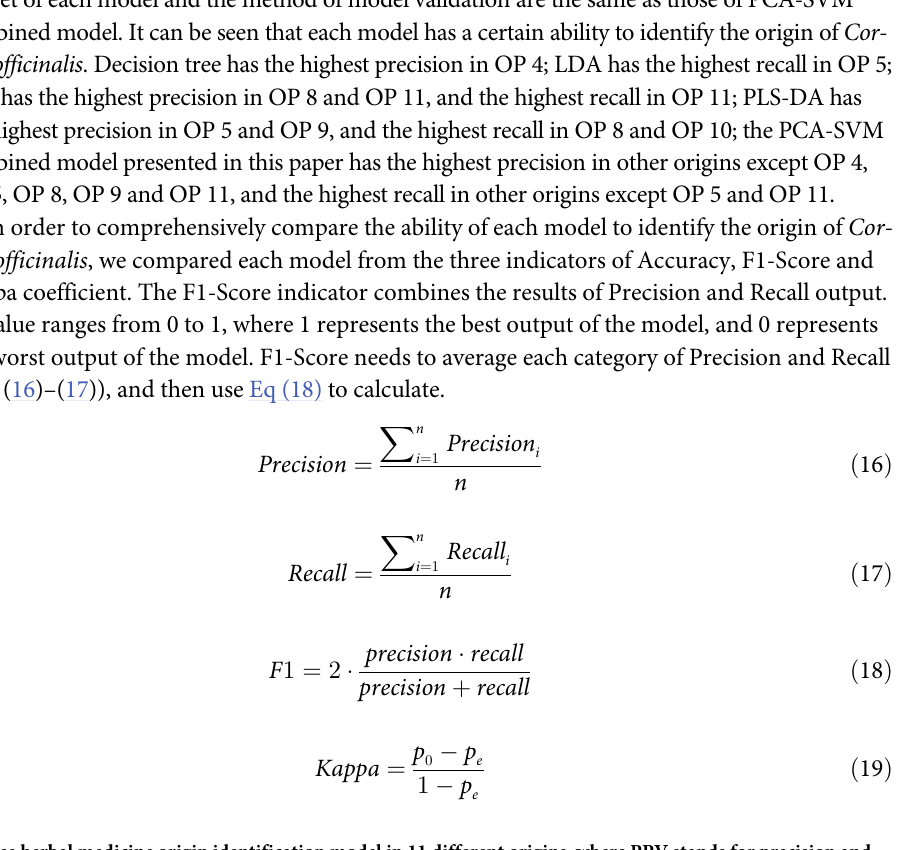
Table 2. Precision and recall (sensitivity) of each Chinese herbal medicine origin identification model in 11 different origins, where PPV stands for precision and TPR stands for sensitivity (values are measured in %). OP Naive